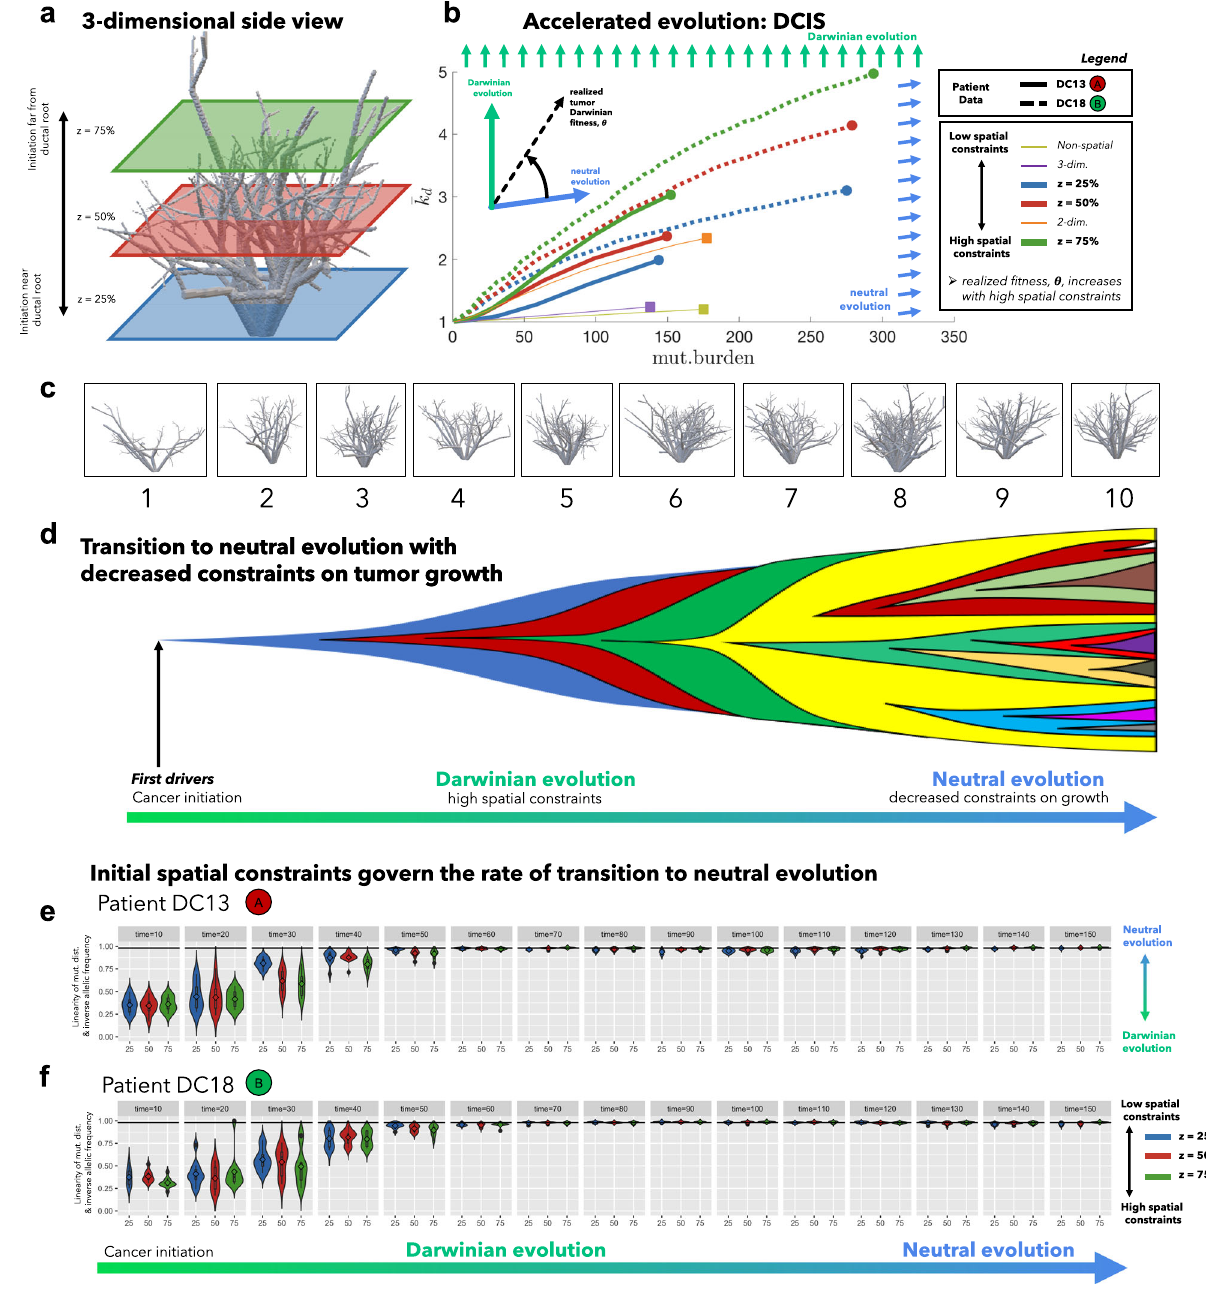
(vertical trajectories) early. At later times, the tumor expands into new unexplored territories, shifting toward neutral trajectories. A tumor originating in a tightly constrained duct enables an accelerated acquisition of drivers early in tumor progression (10 4 cells), which may be a more dangerous, highly homogeneous population of malignant cells that have all acquired new traits such as invasiveness, motility, or metastatic capabilities. These important conclusions are lost when considering identical parameterizations of a non-spatial model (Fig. 4b, yellow), unconstrained two-dimensional model (orange), or uncon- strained three-dimensional model (purple). Neutral evolution has previously been quanti fi ed using the distribution of the cumulative number of mutations in the